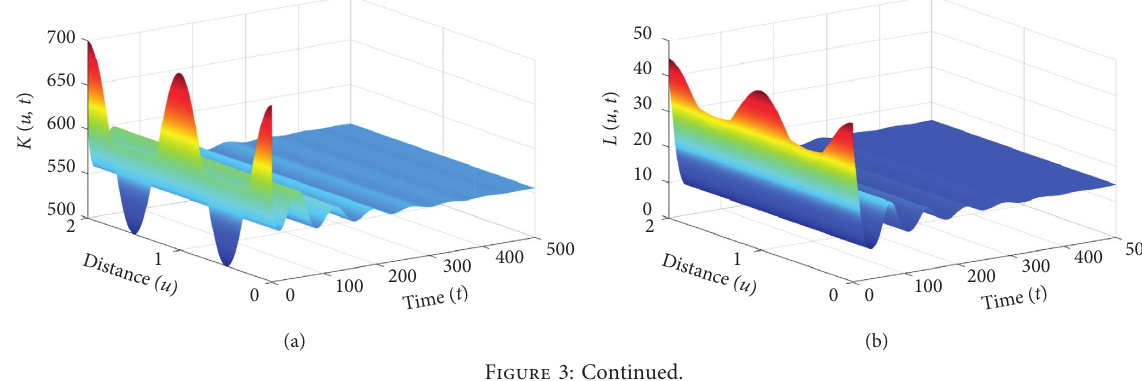
Figure 2: Taking Strategy 1 ( R cells. (b) DENV-infected cells. (c) DENV particles. (d) Heterologous antibodies. (e) Homologous